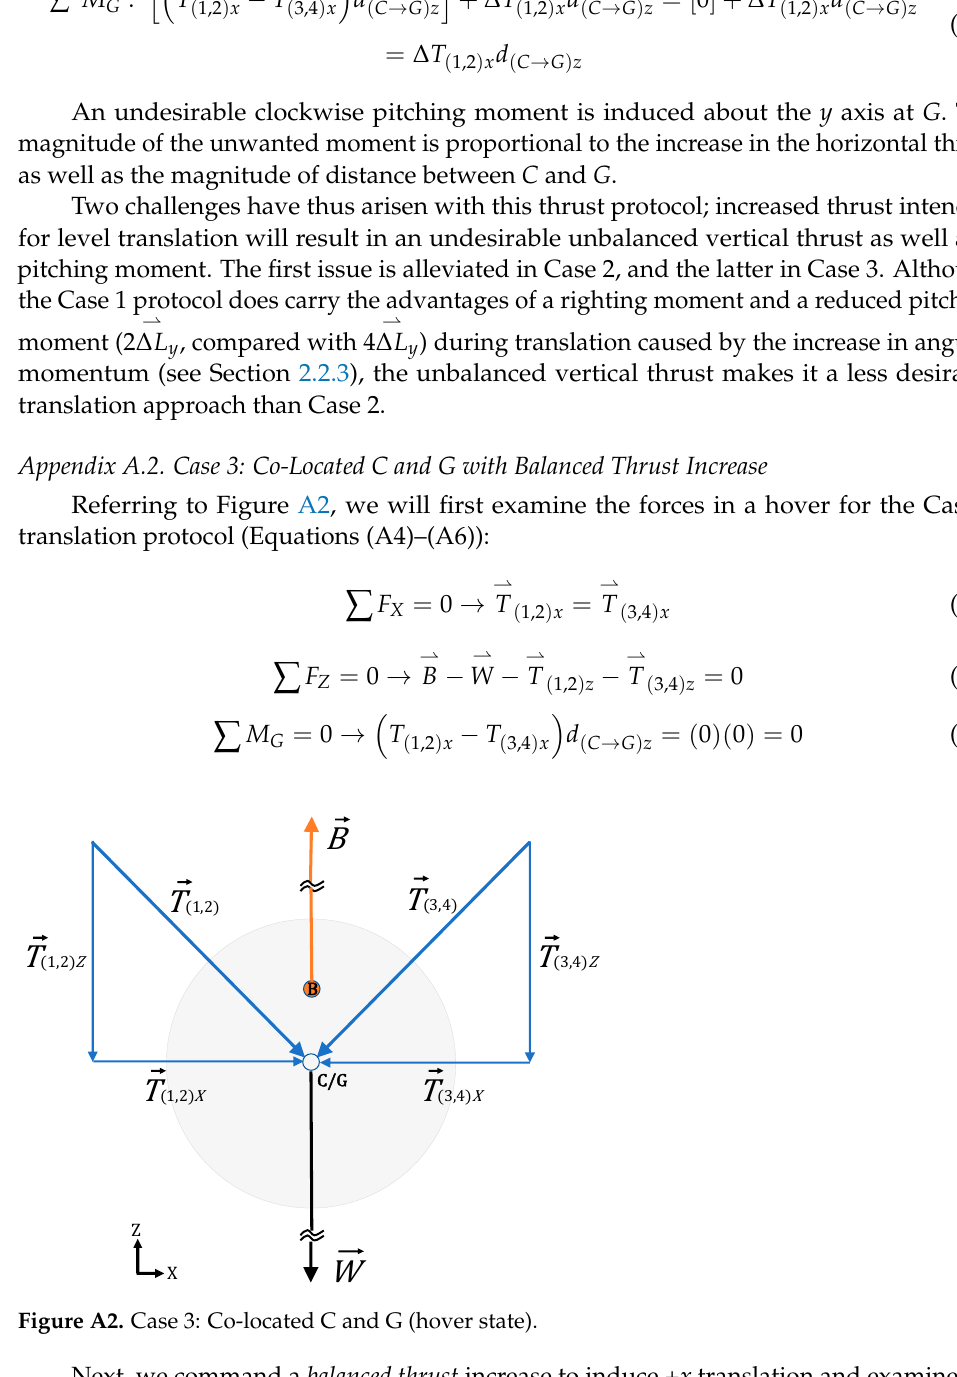
Figure A3. Case 3: Co-located C and G (with balanced thrust increase). The corresponding static equations become ((A7)–(A9)): (cid:3533) 𝐹 (cid:3025) : 𝑇(cid:4652)⃑ ((cid:2869),(cid:2870))(cid:3051) + ∆𝑇(cid:4652)⃑ ((cid:2869),(cid:2870))(cid:3051) − 𝑇(cid:4652)⃑′ ((cid:2871),(cid:2872))(cid:3051) = 𝑇(cid:4652)⃑ ((cid:2869),(cid:2870))(cid:3051) + ∆𝑇(cid:4652)⃑ ((cid:2869),(cid:2870))(cid:3051) − (cid:3427)𝑇(cid:4652)⃑ ((cid:2871),(cid:2872))(cid:3051) − ∆𝑇(cid:4652)⃑ ((cid:2871),(cid:2872))(cid:3051) (cid:3431)